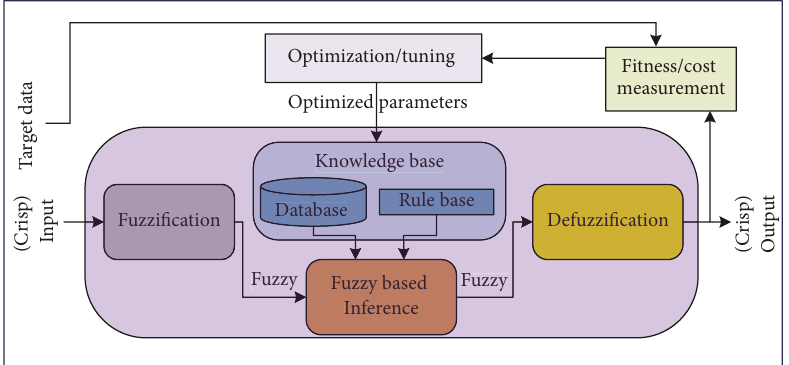
Figure 4: Architecture of fuzzy inference system with optimization or tuning.